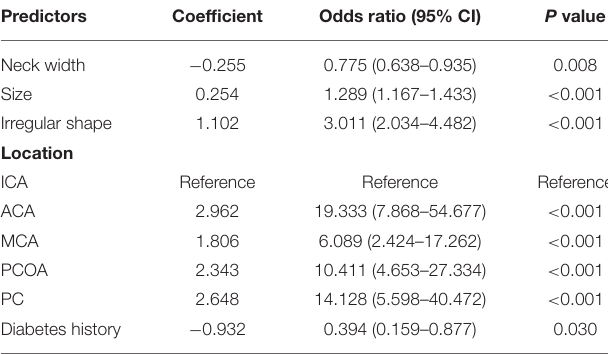
TABLE 2 | Results of multivariable logistic regression